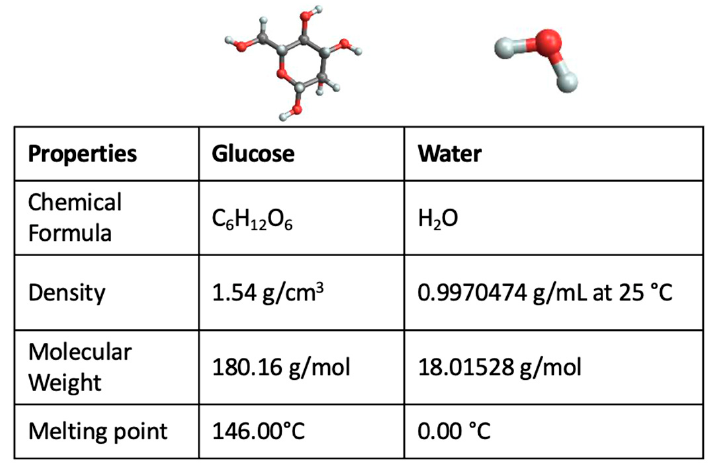
Figure 1. Properties of pure glucose and pure water together with their molecular structures.